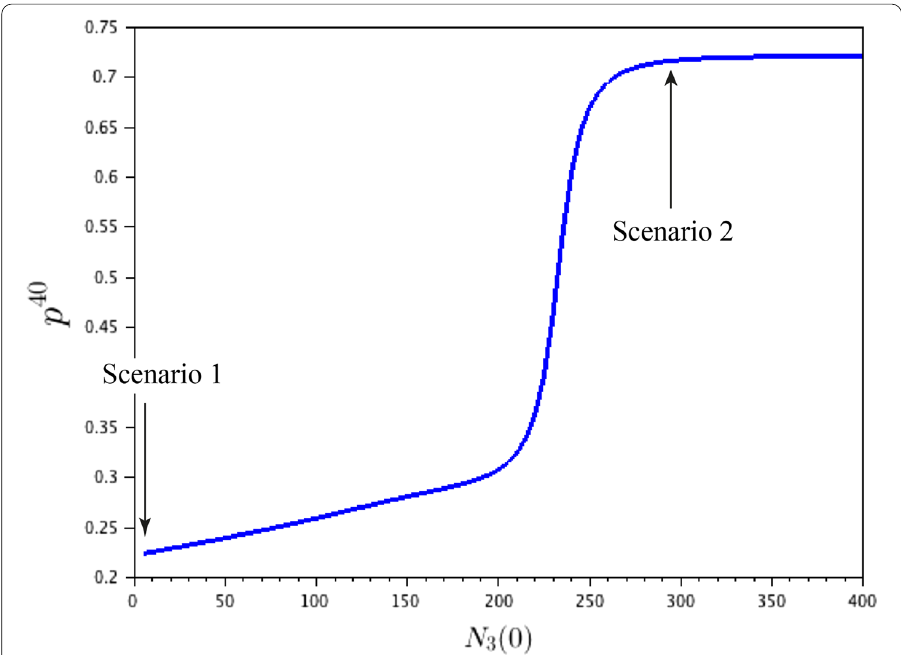
Fig. 10 Proportion of panic individuals p 40 (blue) in node 3 at t = 40 min, as function of the number of individuals N 3 ( 0 ) already present in node 3 at t = 0 . All the parameters are here settled as in scenarios 1 and 2, only N 3 ( 0 ) varies. In particular, scenario 1 is for N 3 ( 0 ) = 5 , while scenario 2 is for N 3 ( 0 ) = 295. Here, the maximal capacity of node 3 is N max 3 = 500 . If the refuge node is quite full from the beginning, panic reaction can get the upper